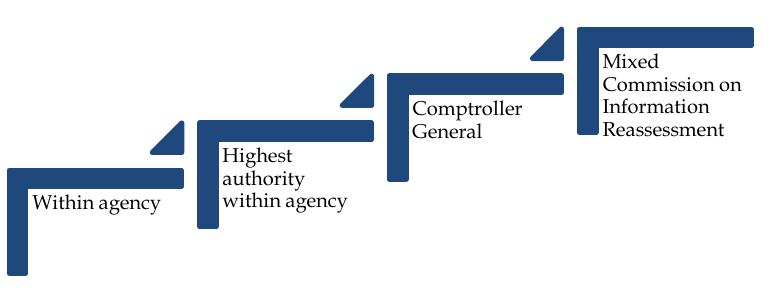
Figure 2: Levels of RTI Appeals in Brazil